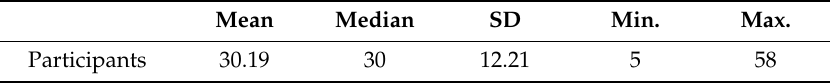
Table 1. Descriptive statistics of participants in eye-tracking